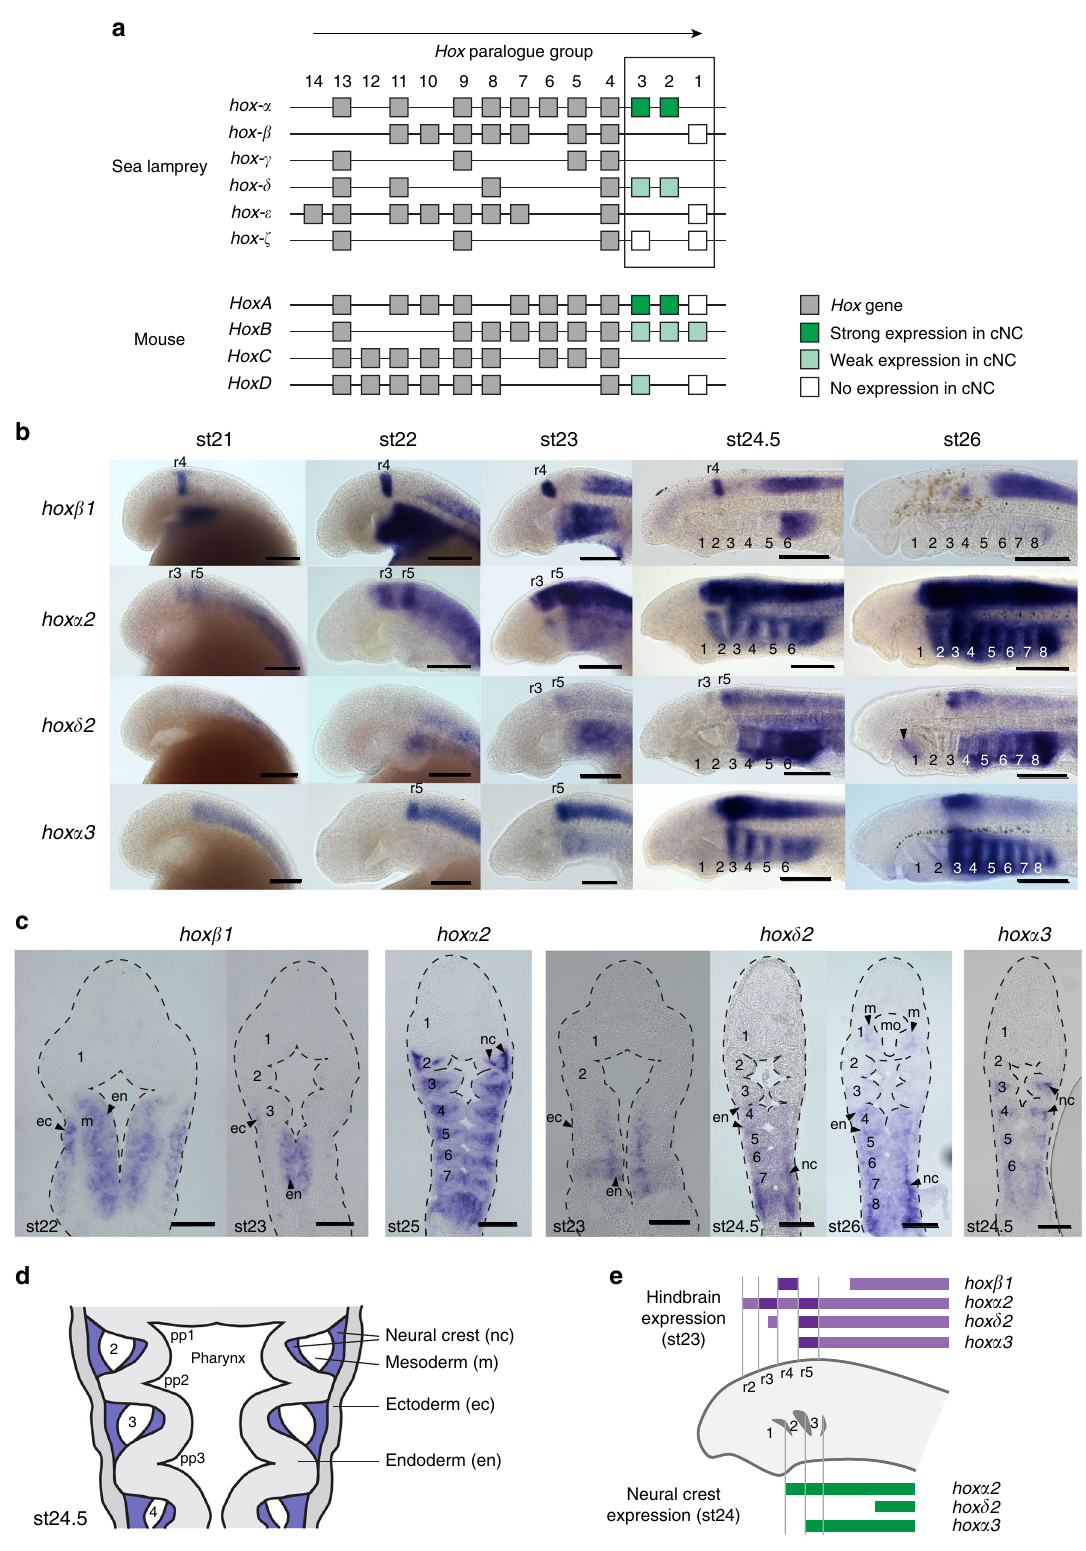
prominently expressed in NC-derived pharyngeal mesenchyme equivalent to crestin reporter expression domains and endogen- ous hox α 2 (Fig. 3d). In gnathostomes, NC Hoxa2 expression is regulated